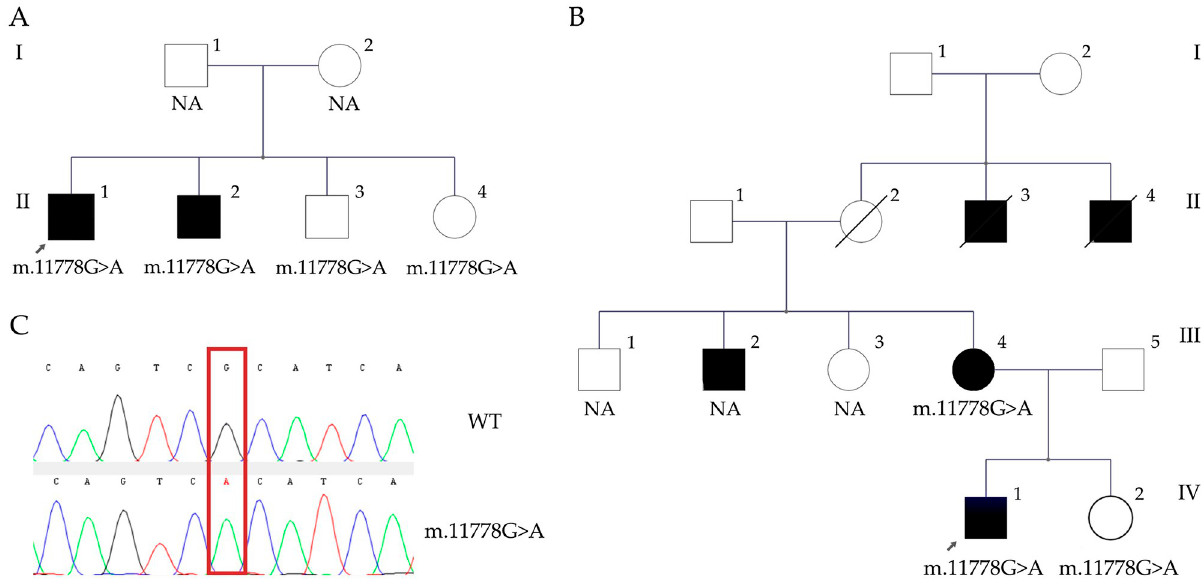
Fig 3. Families with variant m.11778G > A, p.Arg340His, in the MT-ND 4 gene. A, Four members of a family resulted positive for pathogenic variants in MT-ND 4 gene, but only II1 and II2 had developed visual loss at the time of the study. B, A 40 year old patient with diabetes, history of leukemia and sudden bilateral loss of visual acuity (IV1). His non-smoker mother suffered diabetes, polyneuropathy, migraine and visual loss. The sister remains asymptomatic (IV2). C, partial sequence chromatograms of ND4 gene. Red square indicates the location of the base changes at position